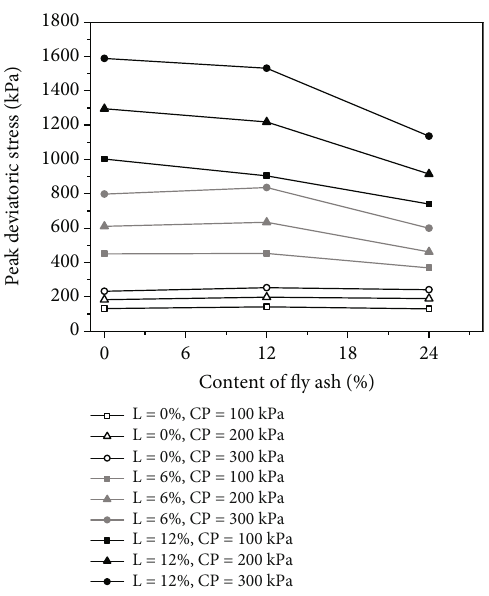
Figure 19: Peak deviatoric stress due to di ff erent content of fl y ash ( FT = 0